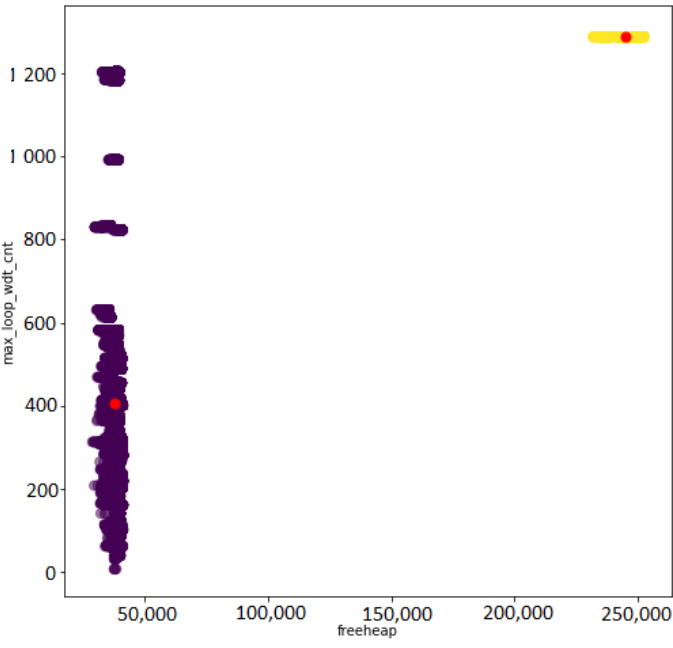
Figure 18. Smart home K-Means clusters.